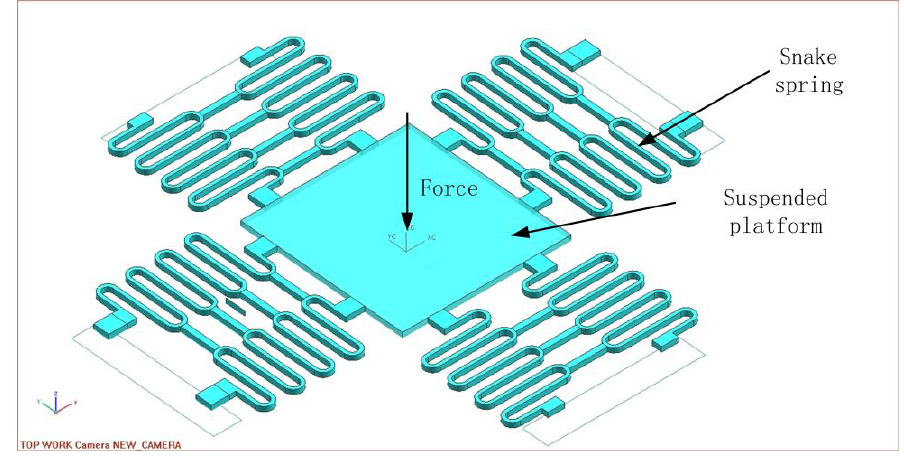
Figure 2. The structure of snake spring with the suspended platform.